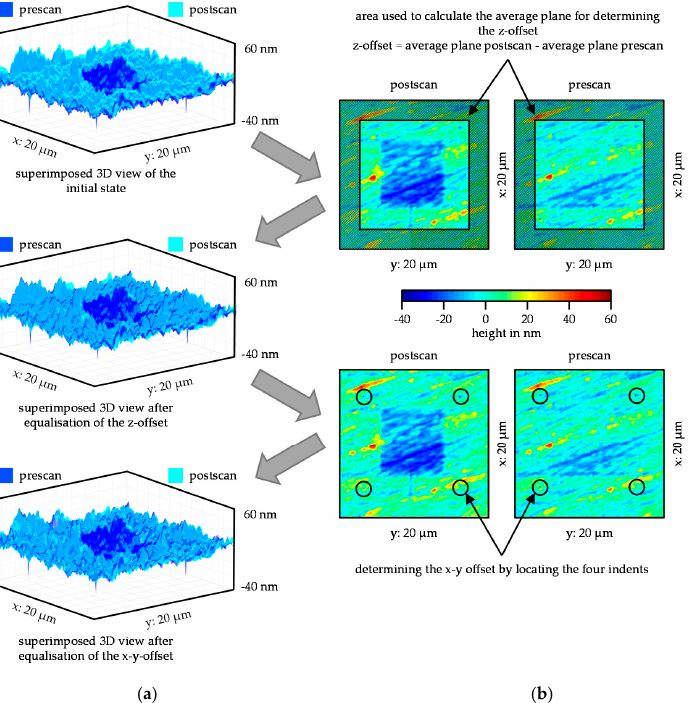
Figure 5. ( a ) Superimposed 3D plots of the pre ‐ scan and post ‐ scan, initial state (top), after correction (middle) of the z ‐ offset, after correction of the x ‐ y ‐ offset (bottom). ( b ) Top view of pre ‐ scan and post ‐ scan to illustrate which areas were used for offset determination. (middle) of the z-offset, after correction of the x-y-offset (bottom). ( b ) Top view of pre-scan and post-scan to illustrate which areas were used for offset